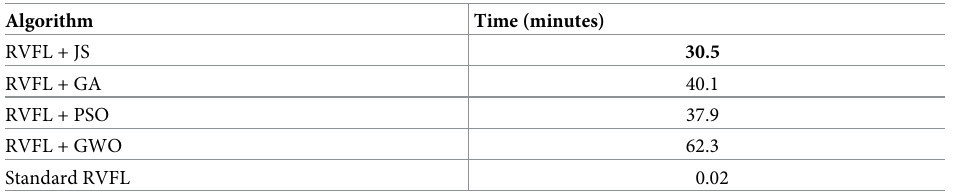
Table 11. Execution time of RVFL+ JS against other metaheuristic algorithms.